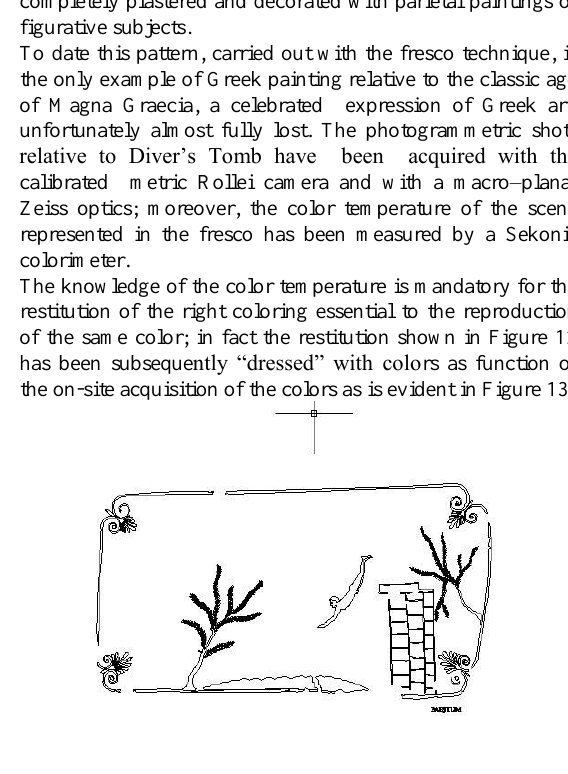
Figure 12. Restitution of Diver’s